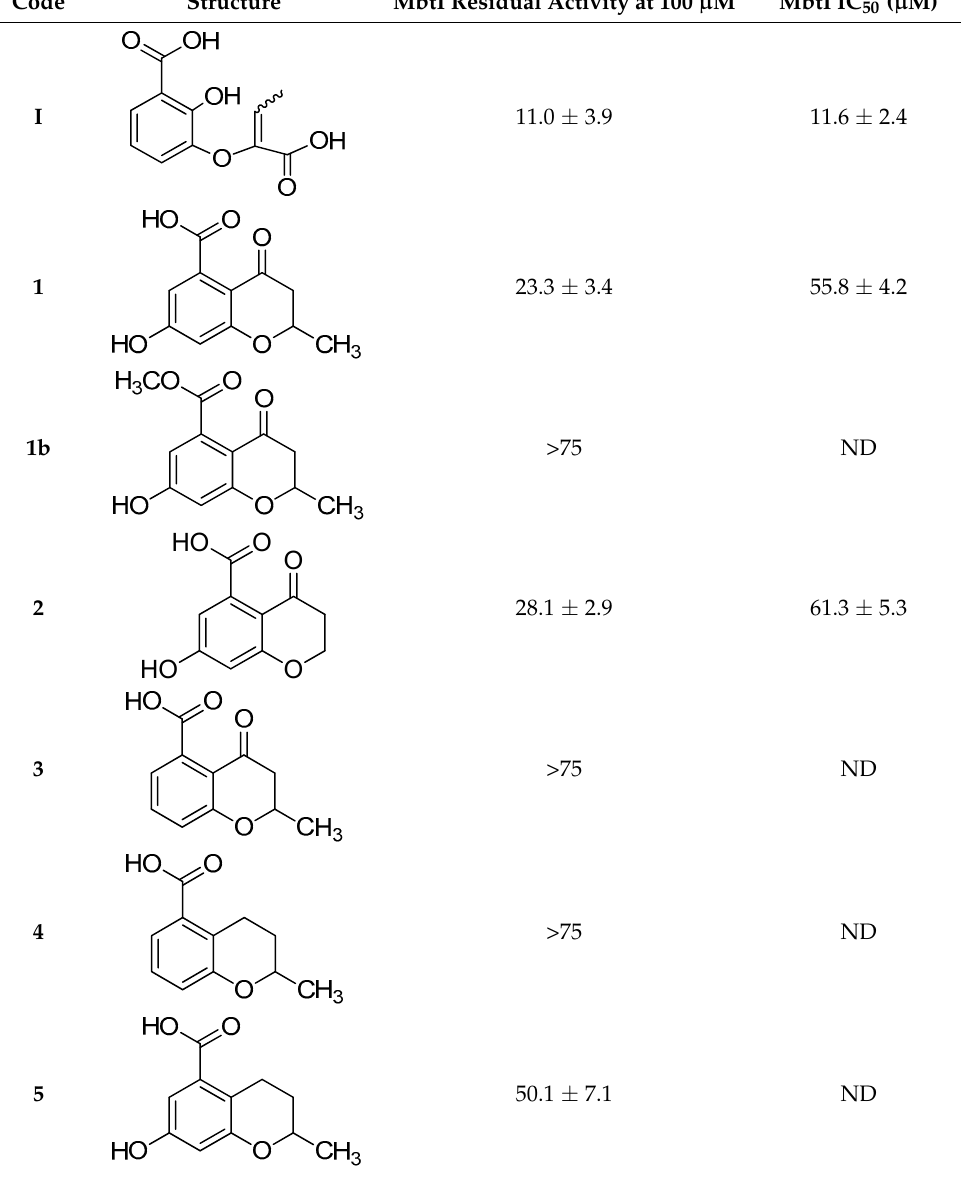
Table 1. In vitro activity of compounds 1 – 5 and I .